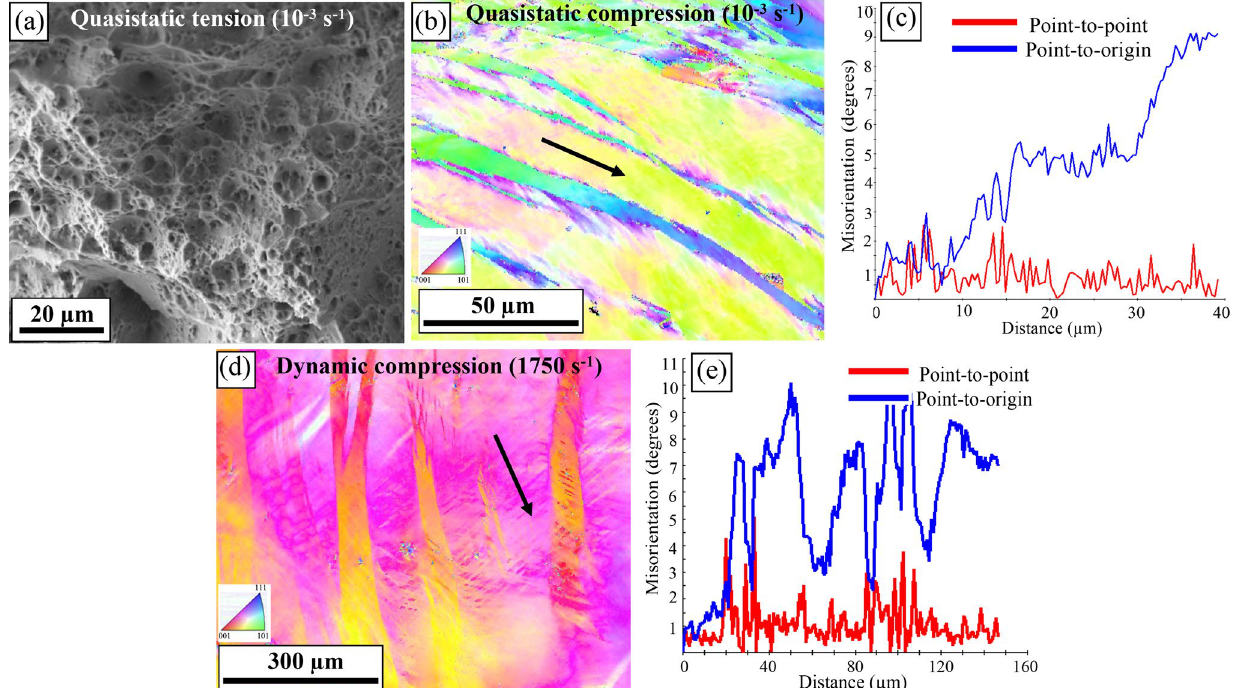
Figure 4. Microstructural characterization after deformation at quasi-static and dynamic strain rates: ( a ) fracture surface after quasi-static tensile test showing ductile mode of fracture; ( b ) IPF image of the deformed microstructure after quasi-static compression test showing deformed grains with deformation bands; ( c ) misorientation profile along the arrow in Fig. 3b indicating an average misorientation of ~ 5–6 degrees; ( d ) IPF image of the deformed microstructure after SHPB test at a strain rate of 1750 s −1 showing highly deformed grains and high density of deformation bands; ( e ) misorientation profile along the arrow in Fig. 3d indicating an average misorientation of ~ 7–8